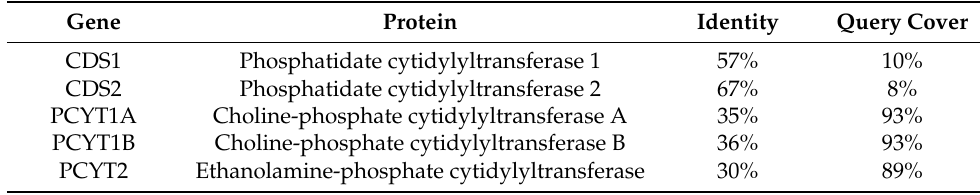
Table 1. Sequence identities of homologs genes with the TagD gene calculated utilizing the BLAST 2.0 algorithm.